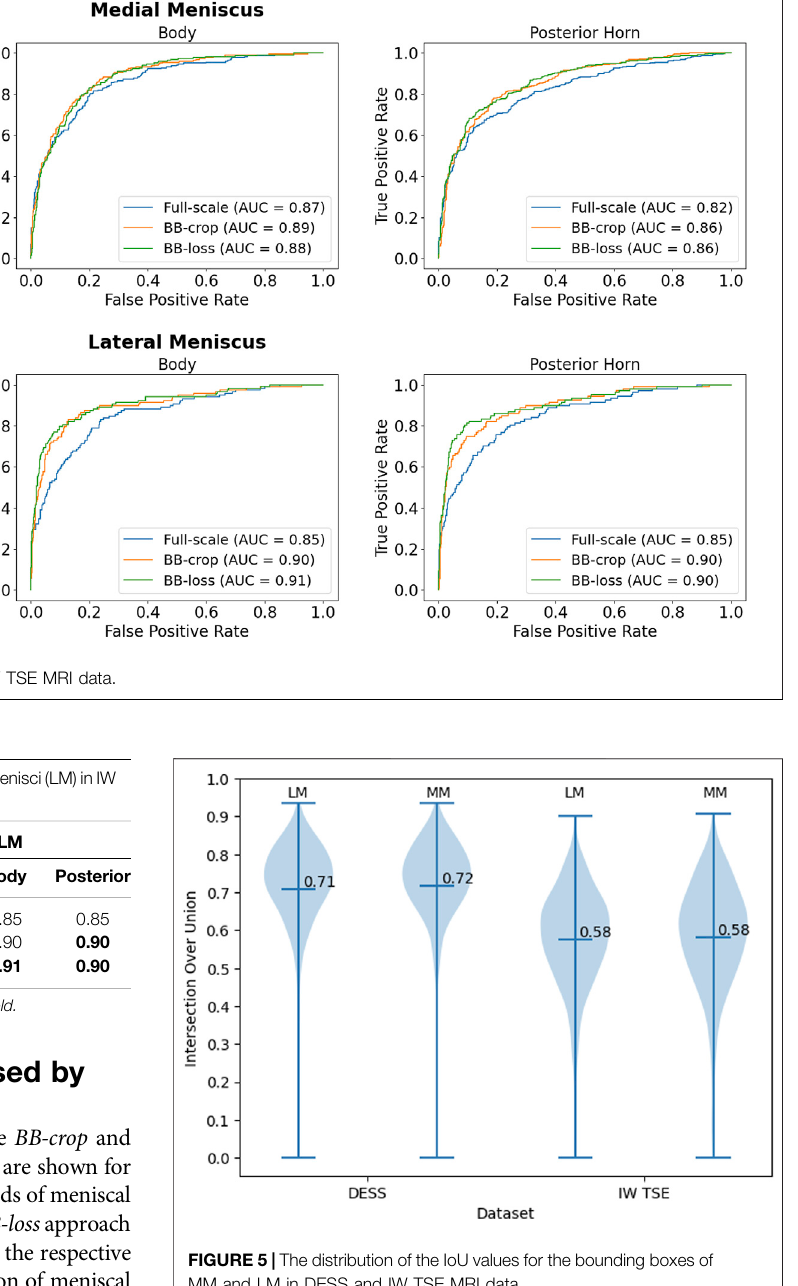
FIGURE 5 | The distribution of the IoU values for the bounding boxes of MM and LM in DESS and IW TSE MRI